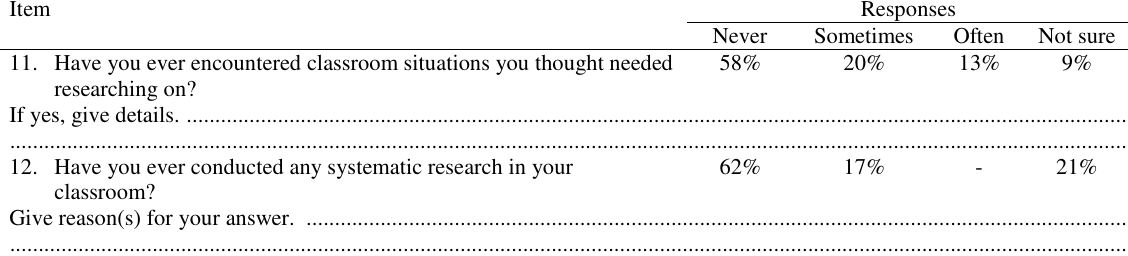
Table 3 Crosstabs on the theme conduct of research Item